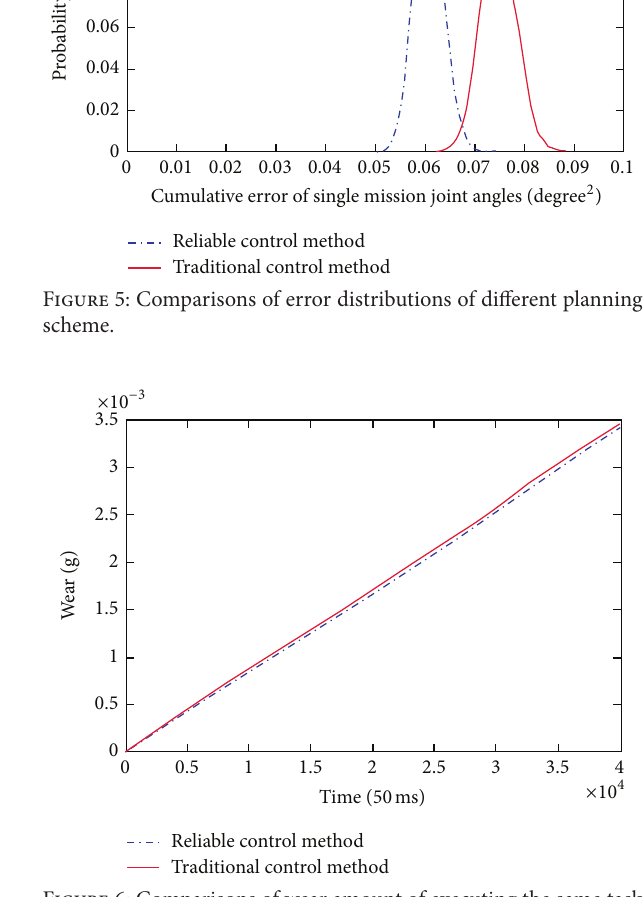
Figure 6: Comparisons of wear amount of executing the same task